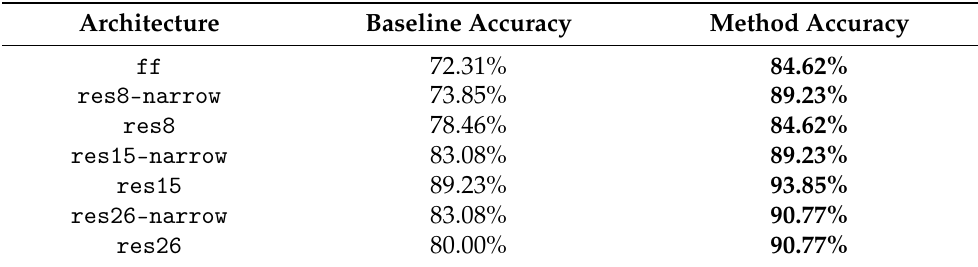
Table 15. Test accuracy after using Google Speech Commands data set [38] as additional target samples with repeating each Lithuanian sample 10 times. The best result for each architecture is highlighted.